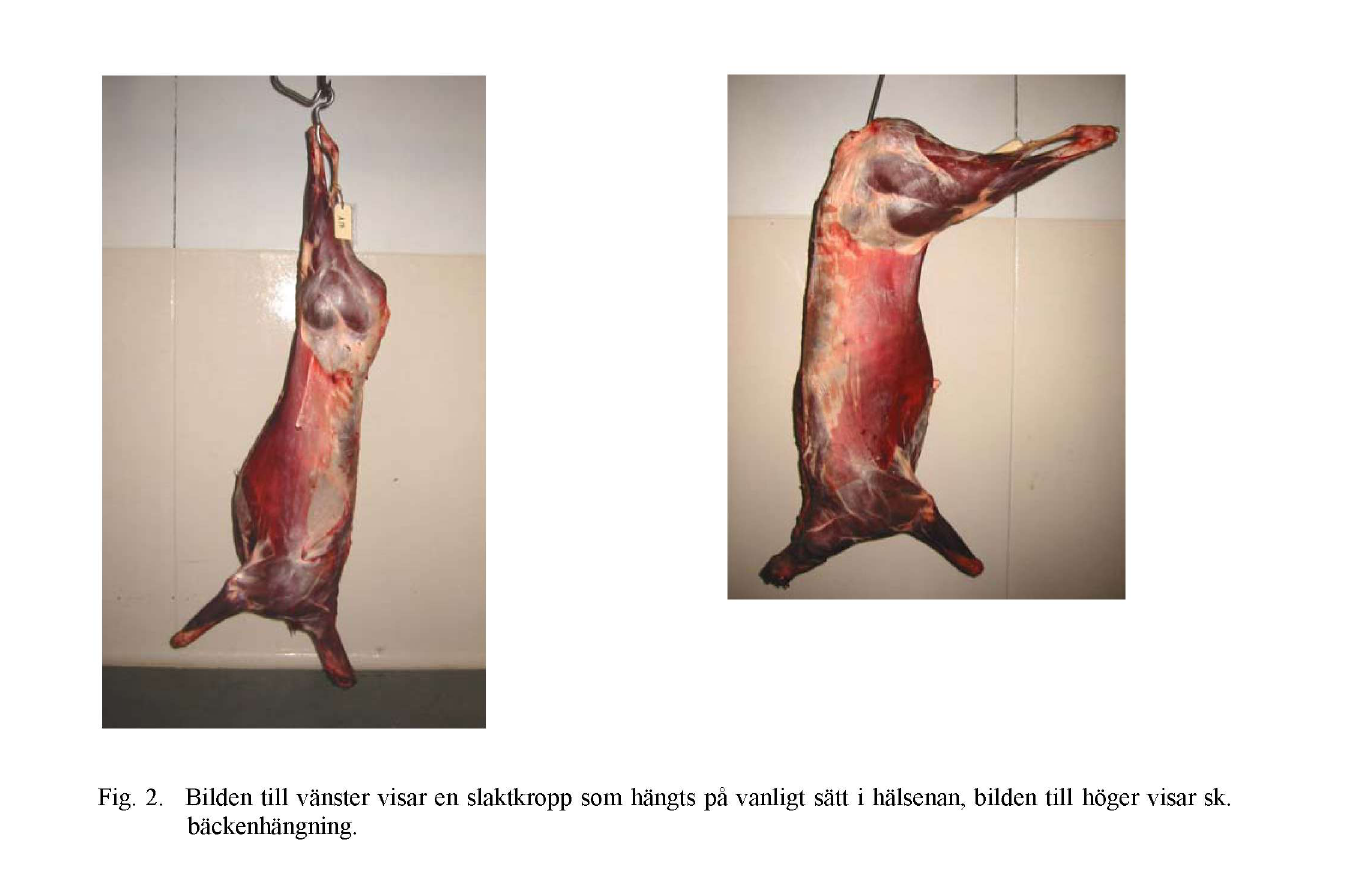
Fig. 2. Bilden till vånster visar en slaktkropp som hångts på vanligt sått i hålsenan, bilden till höger visar sk.